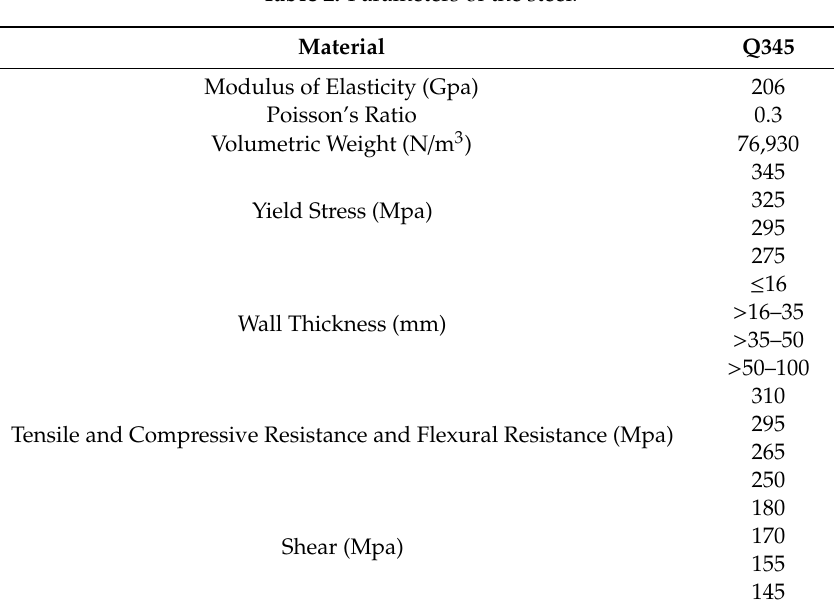
Table 2. Parameters of the steel.